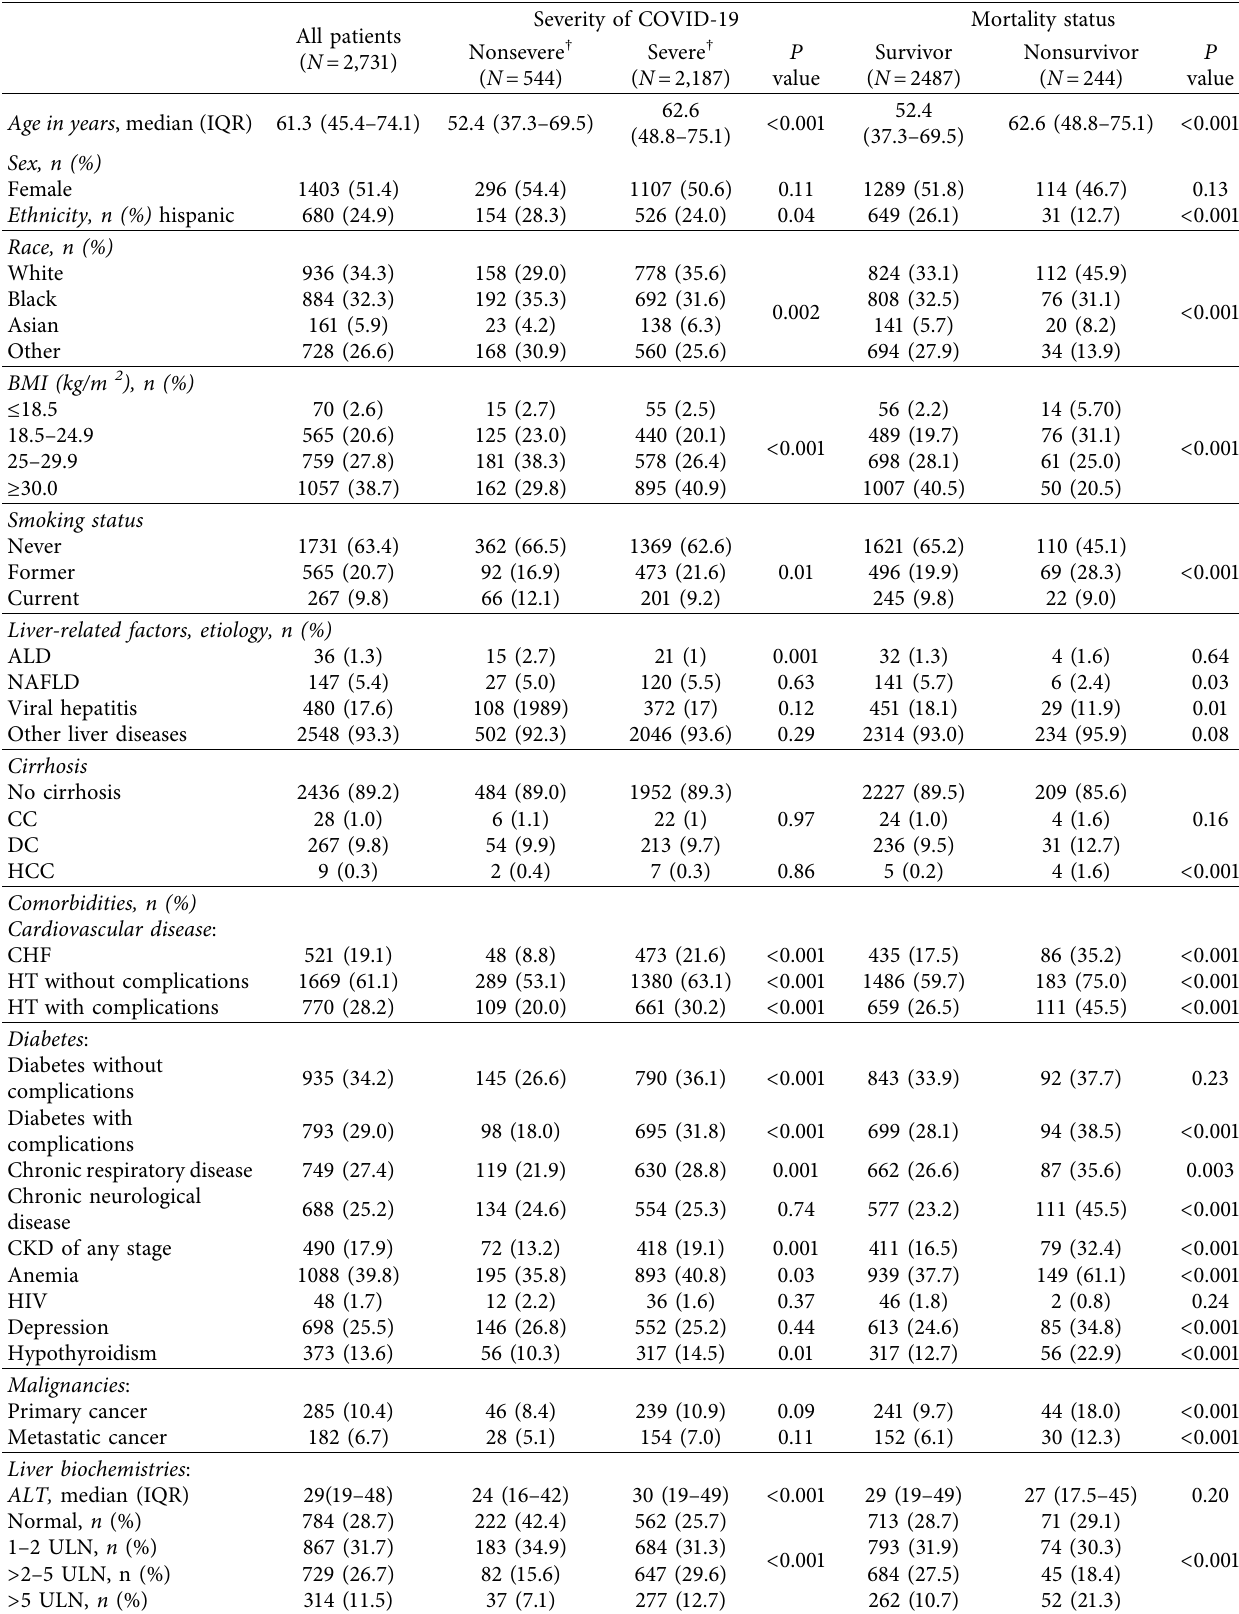
Table 1: Baseline, clinical characteristics, and outcomes of patient with chronic liver disease and a positive test for